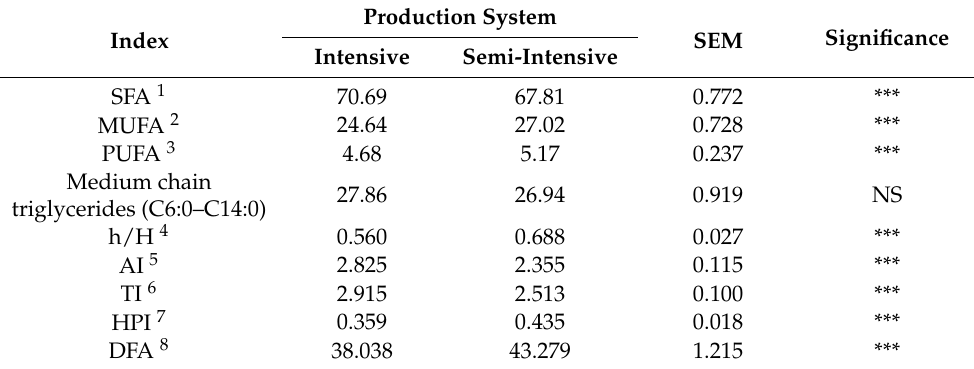
Table 4. Effect of the production system on sheep milk nutritional